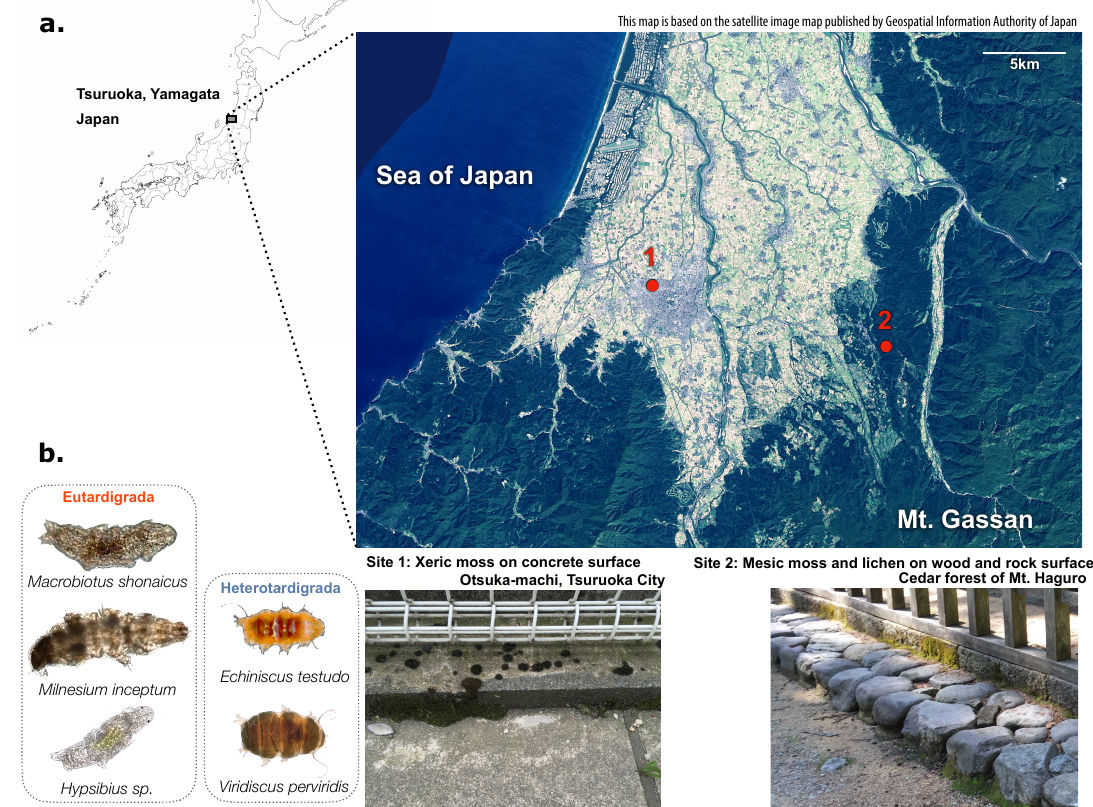
Figure 1. Details of the sampling location. ( a ) Map of sampling location (above) and photos of the sampling site (below). Site 1 is within Tsuruoka city, and site 2 is in the cedar forest of Mt. Haguro. This map is based on the satellite image map published by the Geospatial Information Authority of Japan. ( b ) Microscope images of five tardigrades morphologically identified in site 1: xeric